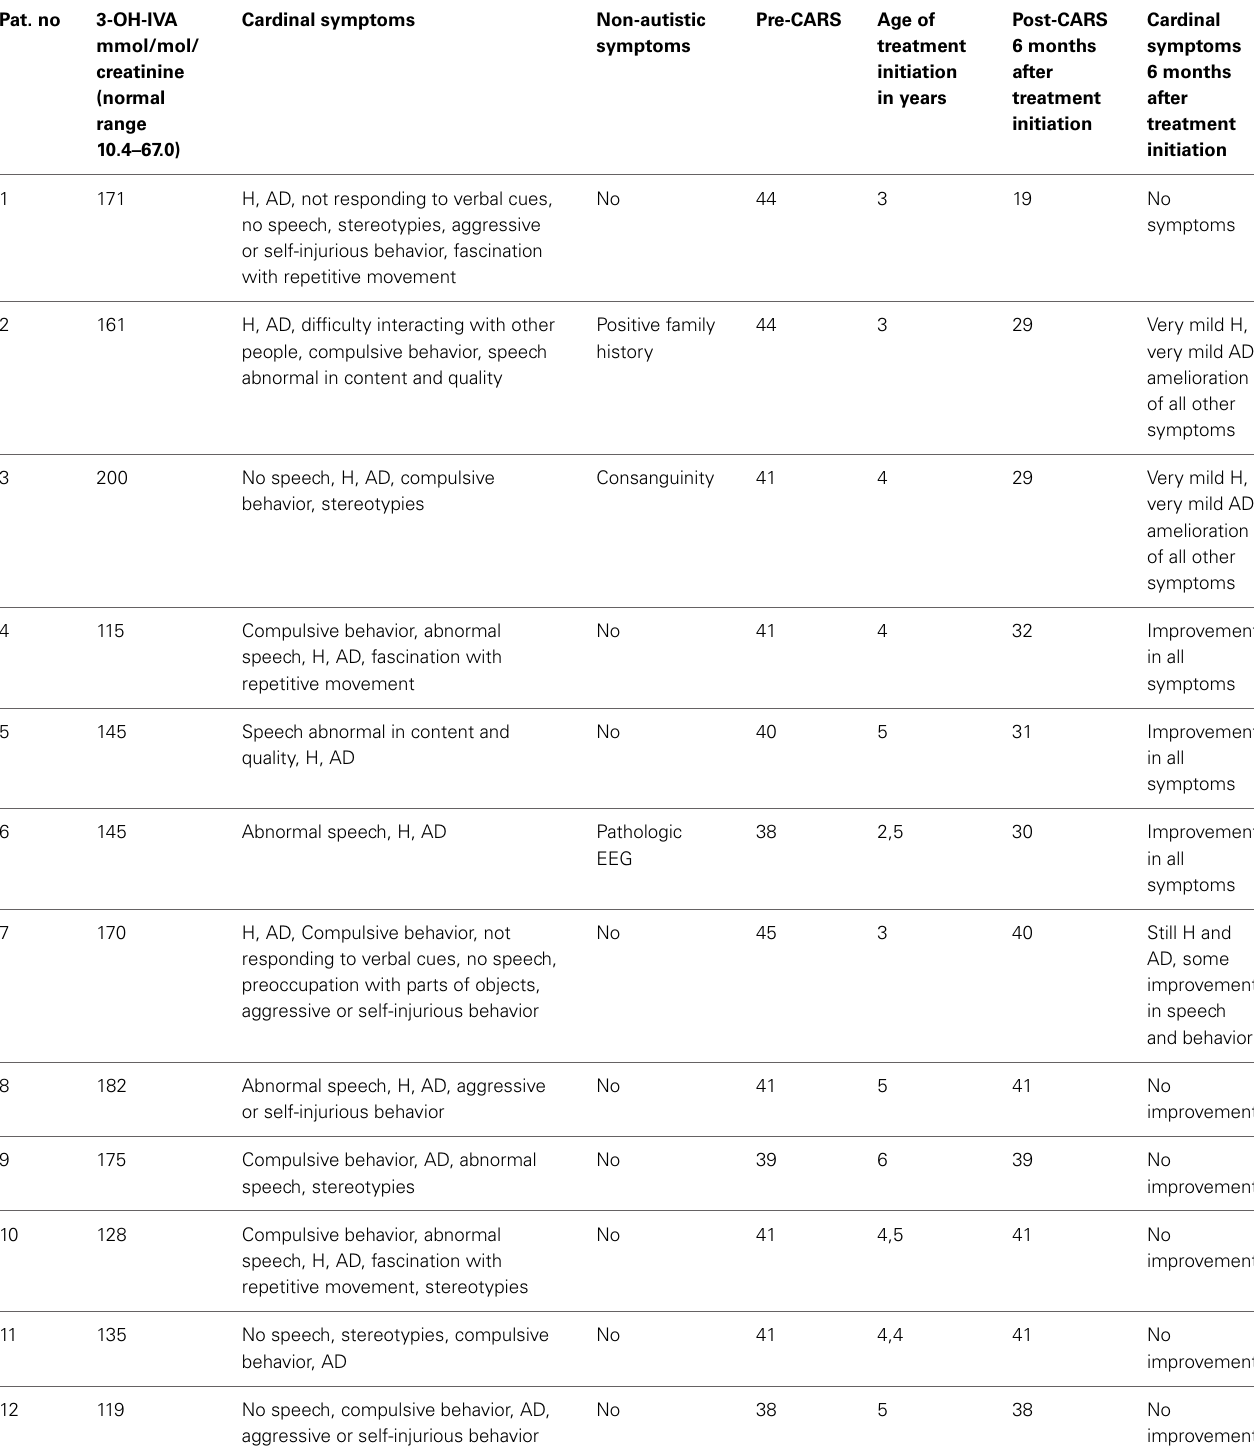
Legend to table: > 12 unit difference is considered significant improvement; 8–12 unit, average improvement; 2–8 units, minor improvement. Note that a score of > 30 on the CARS is indicative of autism. Patients were not undergoing adjuvant therapy during biotin intervention. Abbreviations: 3-OH-IVA, 3-hydroxyisovaleric acid; attention deficit, AD; hyperactivity,